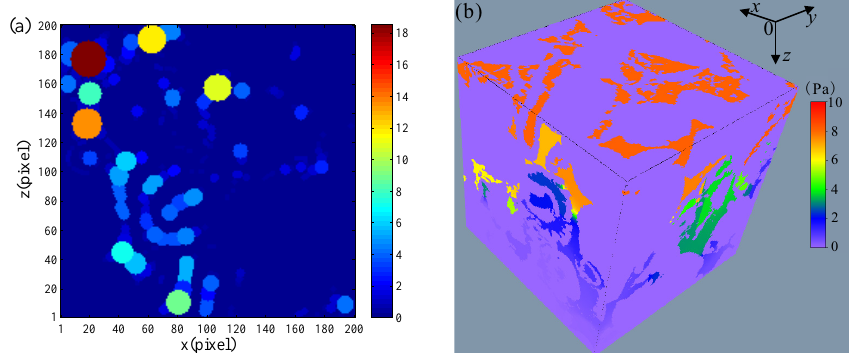
Figure 20. The distribution of coefficients wy and pressures of carbonate digital rock C1 after grid coarsening two times. ( a ) The calculation results of coefficients wy for one-cell thick layer in direction of y . ( b ) The fluid pressure distribution of carbonate digital rock C1. The constant pressures at the inlet and outlet faces are 10 Pa and 0 Pa, respectively.